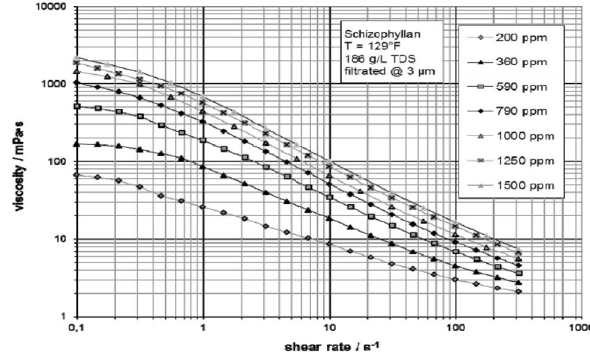
Fig. 8 Viscosity versus shear rate of Schizophyllan (from Leonhardt et al.